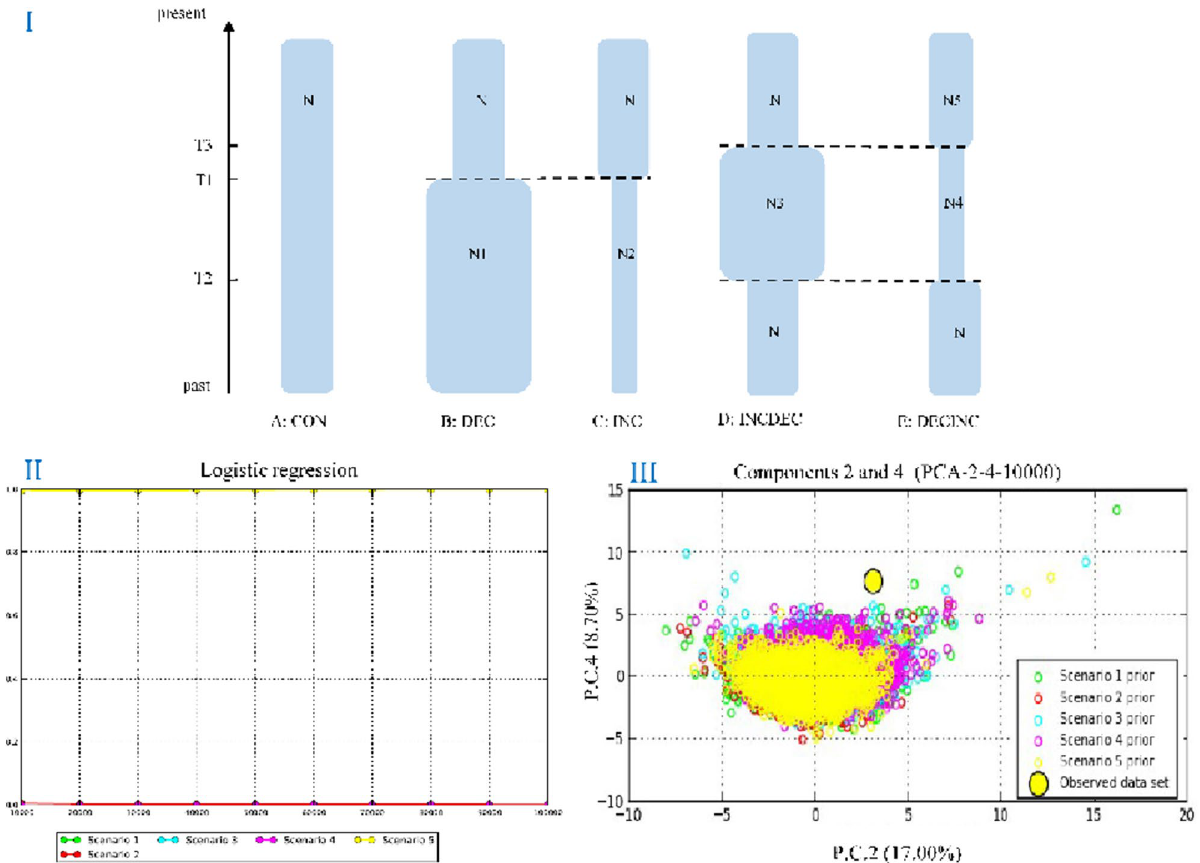
Figure 8. (I) Schematic representation of five demographic scenarios for Trichiurus nanhaiensis tested by approximate Bayesian computation (ABC). Time and effective population size are not to scale. (II) The results of a logistical model comparing posterior probability of each scenario with the number of simulations used to calculate it. (III) The prior distribution of parameters corresponding to the five scenarios tested. Colors reflect each